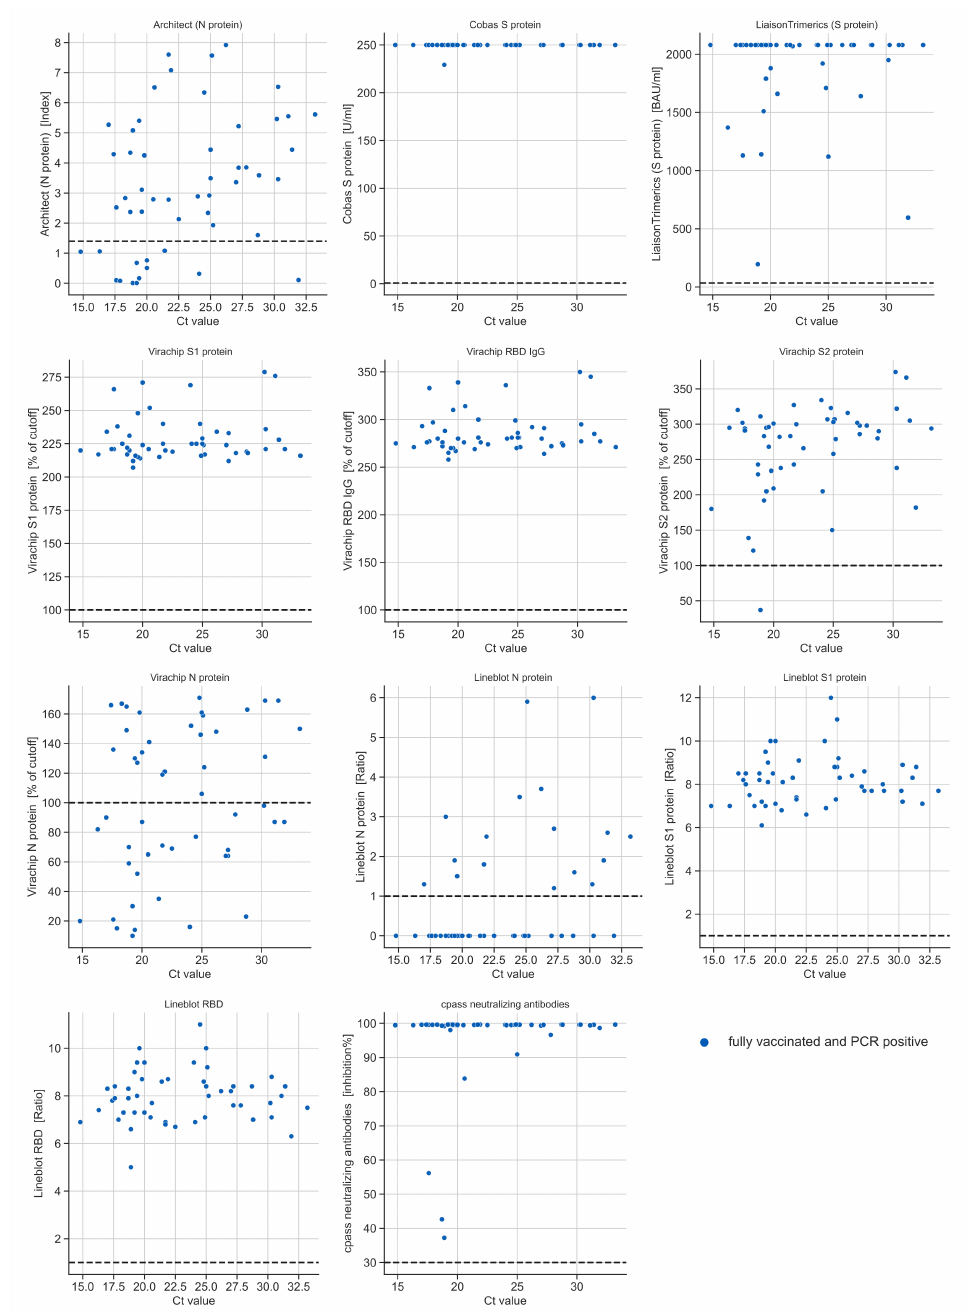
Figure A3. Relationship between measurement values for each assay with Ct values (PCR positive only). Dashed line represents cut-off value. Corresponding Spearman Rank correlation coefficients are summarized in Table